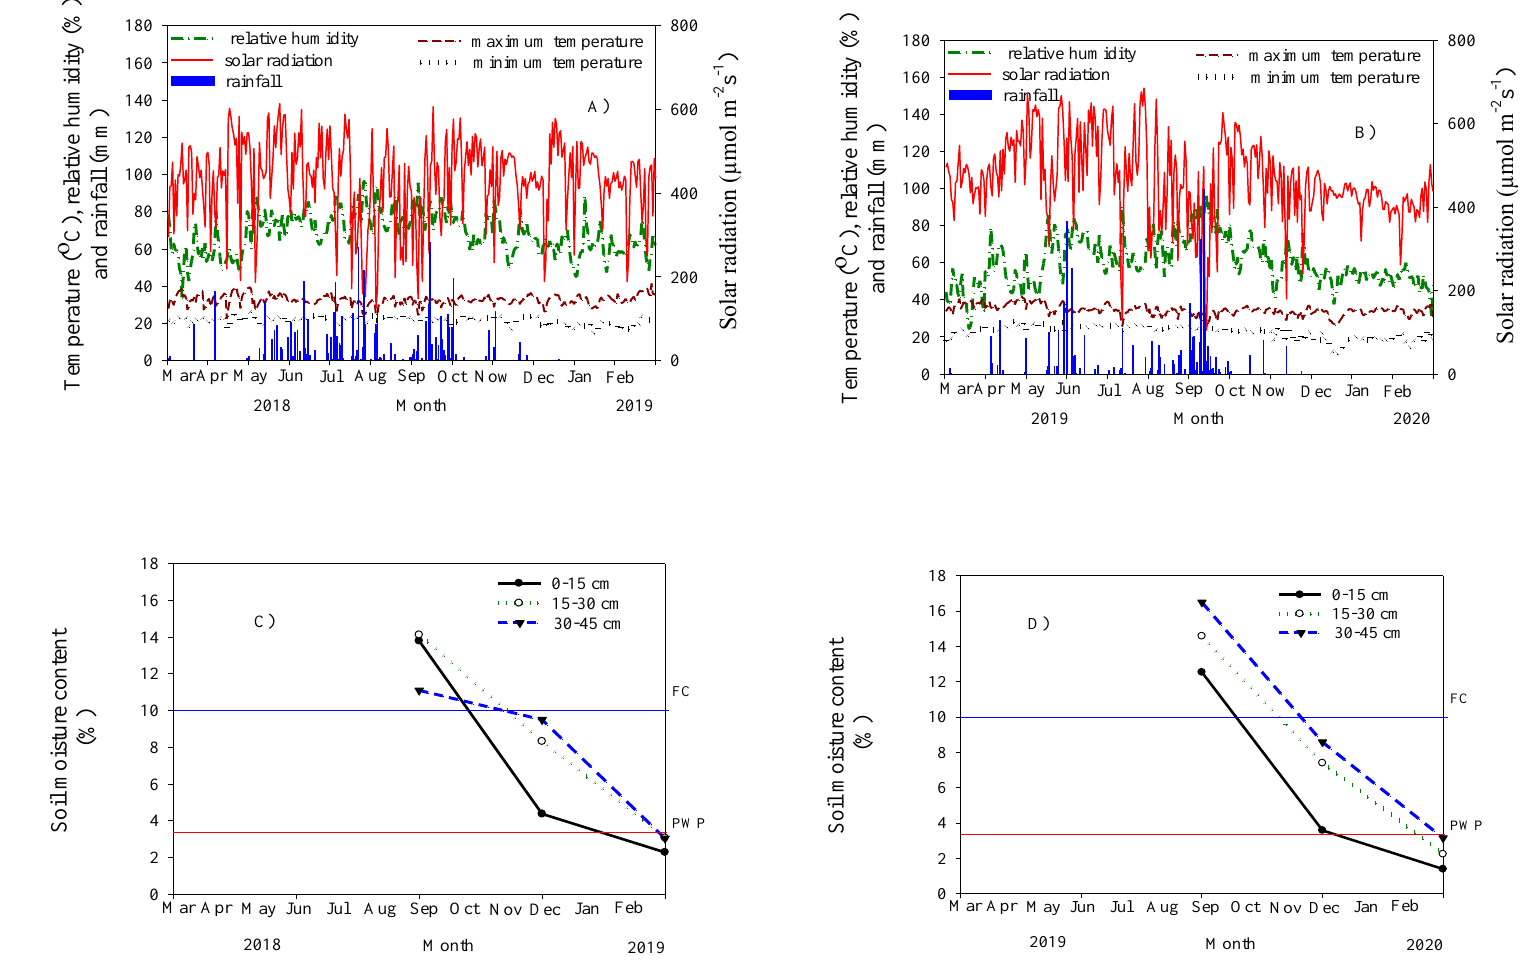
Figure 3. Weather conditions for 2018/2019 ( A ) and 2019/2020 ( B ) at Khon Kaen University, Thailand. Soil moisture contents at three different soil depths for 2018/2019 ( C ) and 2019/2020 ( D ) (FC = field capacity and PWP = permanent wilting point).